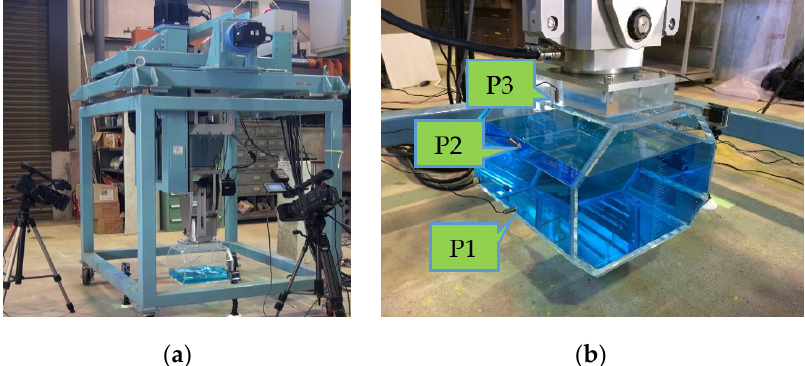
Figure 1. ( a ) Overview of the forced oscillation machine for sloshing tests and ( b ) a photograph of the prismatic tank.